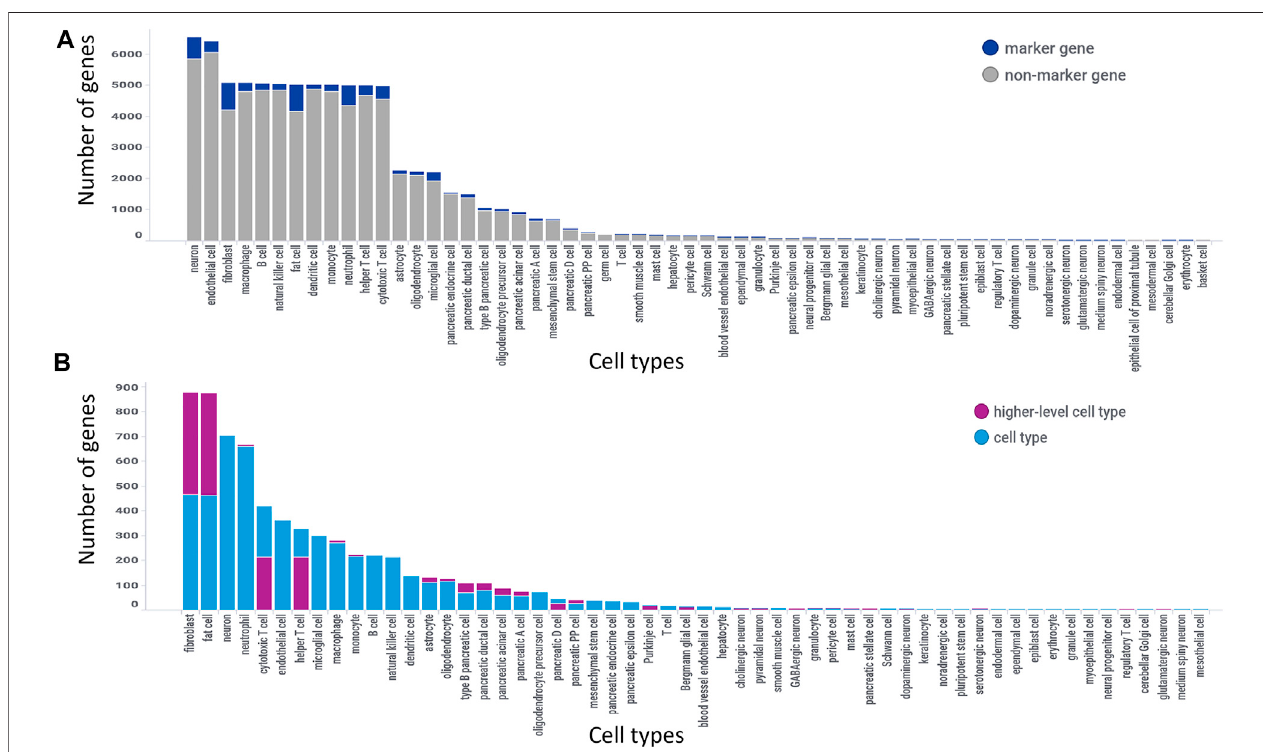
FIGURE4| GeneMarkeRsummarystatistics. (A) Numberofmarkergenesidenti fi ed(darkblue)outofallgenesanalyzedpercelltype(lengthofbar). (B) Numberof markergenesreclassi fi edasahigher-levelcelltypemarker(purple)andnumber ofmarkergenesclassi fi edascelltype-speci fi cmarker(lightblue)outofallmarkergenes identi fi ed for that cell type (length of bar). Figure 2B is fi ltered to the marker genes, i.e., dark blue bars in fi gure 2A . Both fi gures are sorted from largest to smallest number of genes.